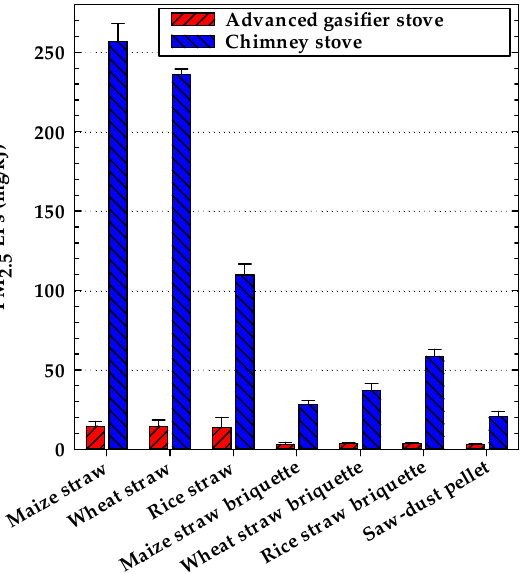
Figure 3. PM 2.5 EFs for raw crop straw, biomass briquettes, and pellets burned in the advanced biomass gasifier cooking stove and the chimney cooking stove.